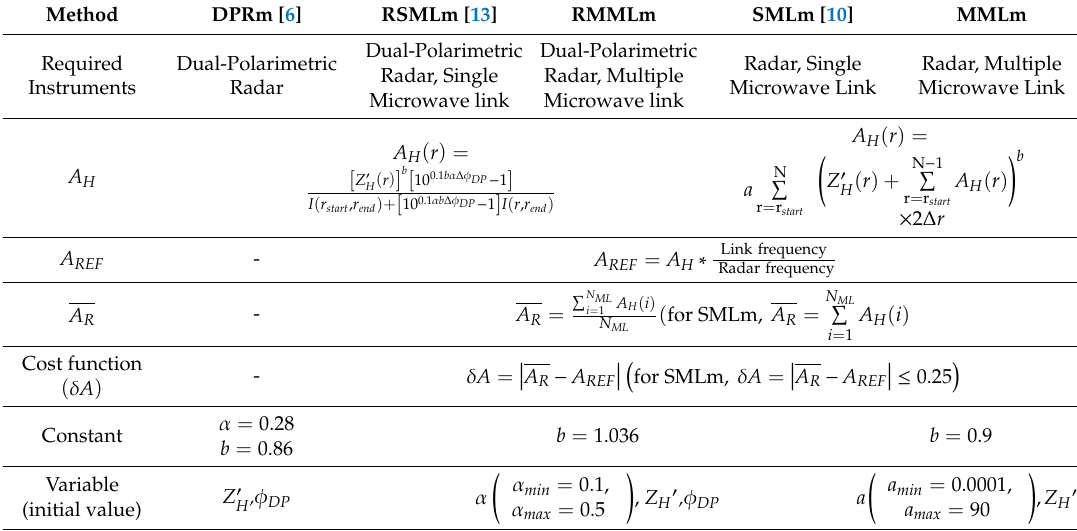
Figure 2. Flow chart of the five attenuation correction methods. Table 3. Characteristics of the five attenuation correction methods (DPRm: Dual-Polarimetric Radar method, RSMLm: Dual-Polarimetric Radar and Single Microwave Link method, RMMLm: Dual-Polarimetric Radar and Multiple Microwave Link method, SMLm: Single Microwave Link method, MMLm: Multiple Microwave Link